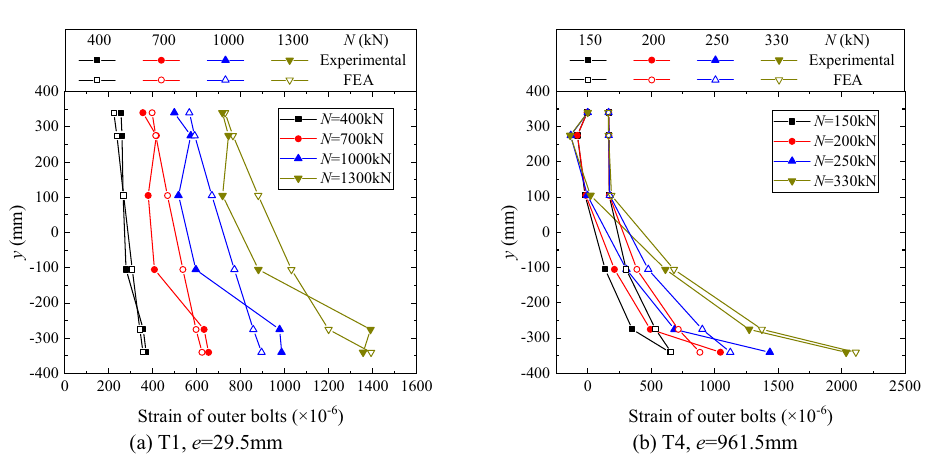
Figure 16. Distributions of outer bolt strain.